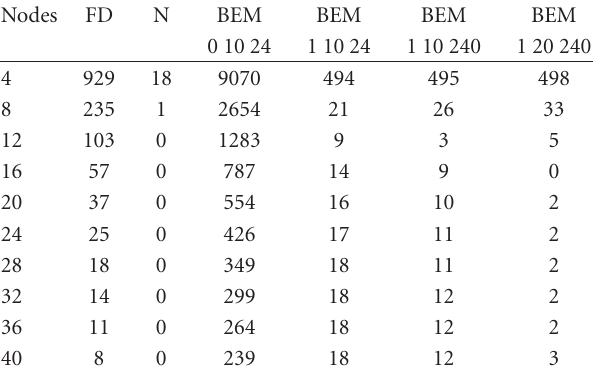
Table 2: Errors in the calculation of the e ff ective multiplication factor for the homogeneous benchmark; the analytical value is k = 0.90145. Relative errors are expressed in pcm for the various models.